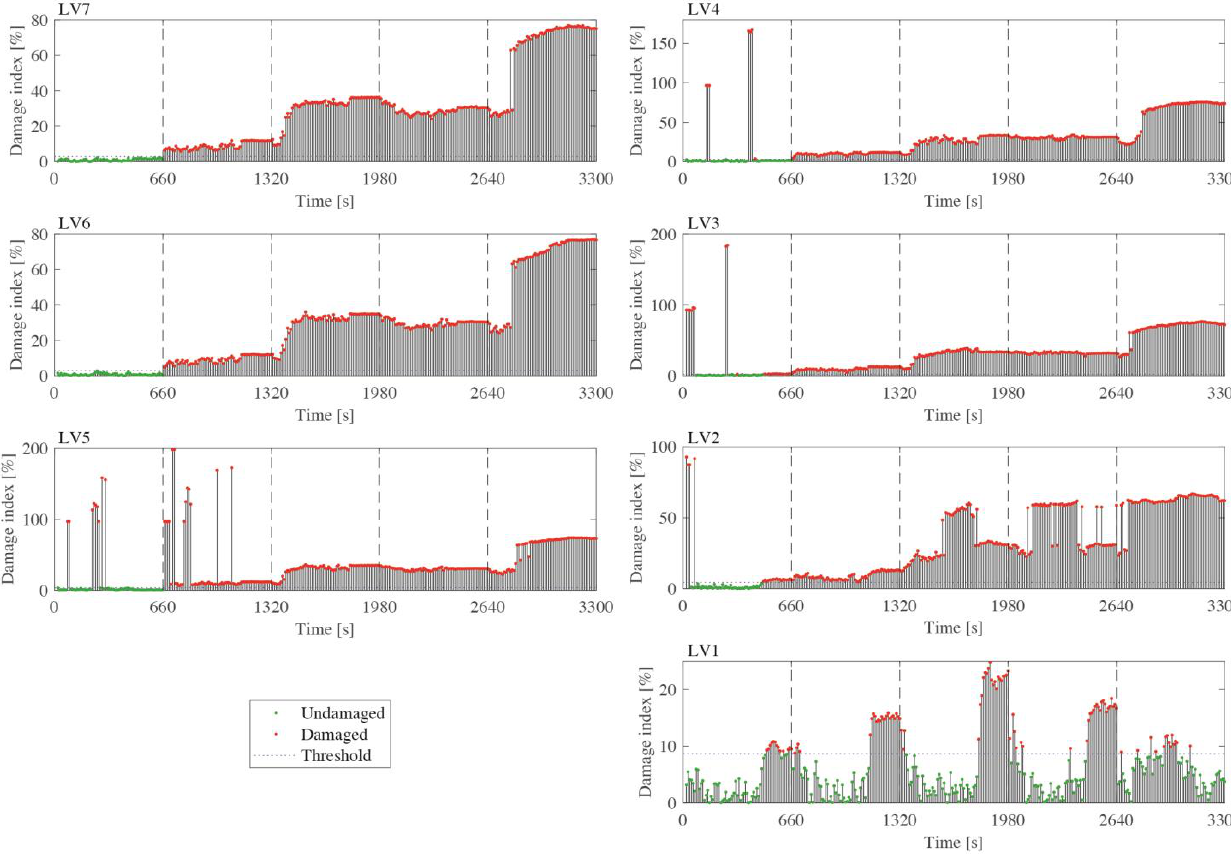
Figure 7. DSF variation identified at each level.